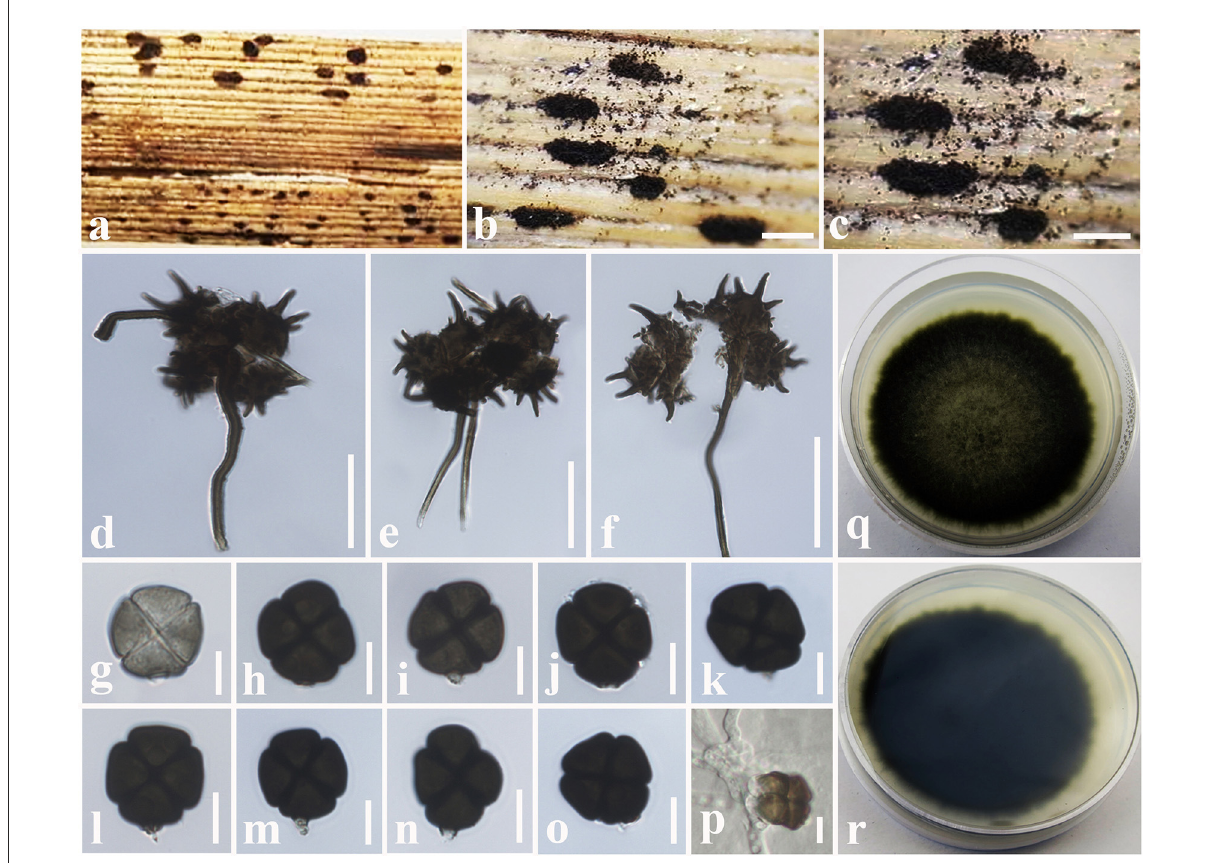
FIGURE12 Spegazzinia tessarthra (MFLU 18-2557, new host record). (a–c) Fungal colonies on a dead stem of Acacia auriculiformis . (d–f) α Conidia with conidiophores. (g – o) β Conidia. (p) A germinating β conidium. (q) Upper side of the culture. (r) Lower side of the culture. Scale bars: (b,c)